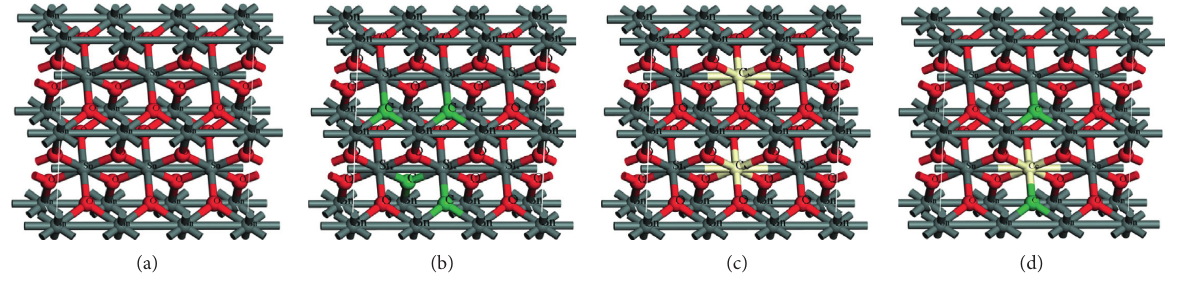
Figure 1: Supercell models: (a) SnO 2 , (b) C-doped, (c) Ce-doped, and (d) Ce-C codoped. Table 1: Lattice constants, cell volumes, and enthalpy change of SnO 2 before and after doping. Data